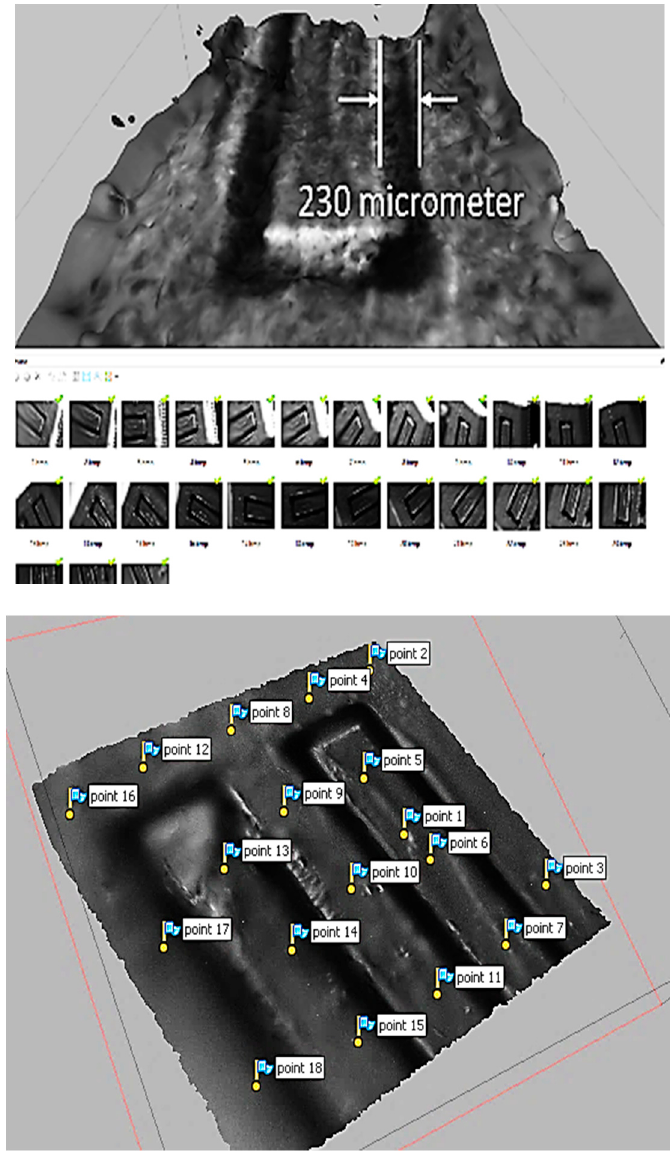
Figure 13. 3D model of the micro-fluidic channel (×30 zoom).